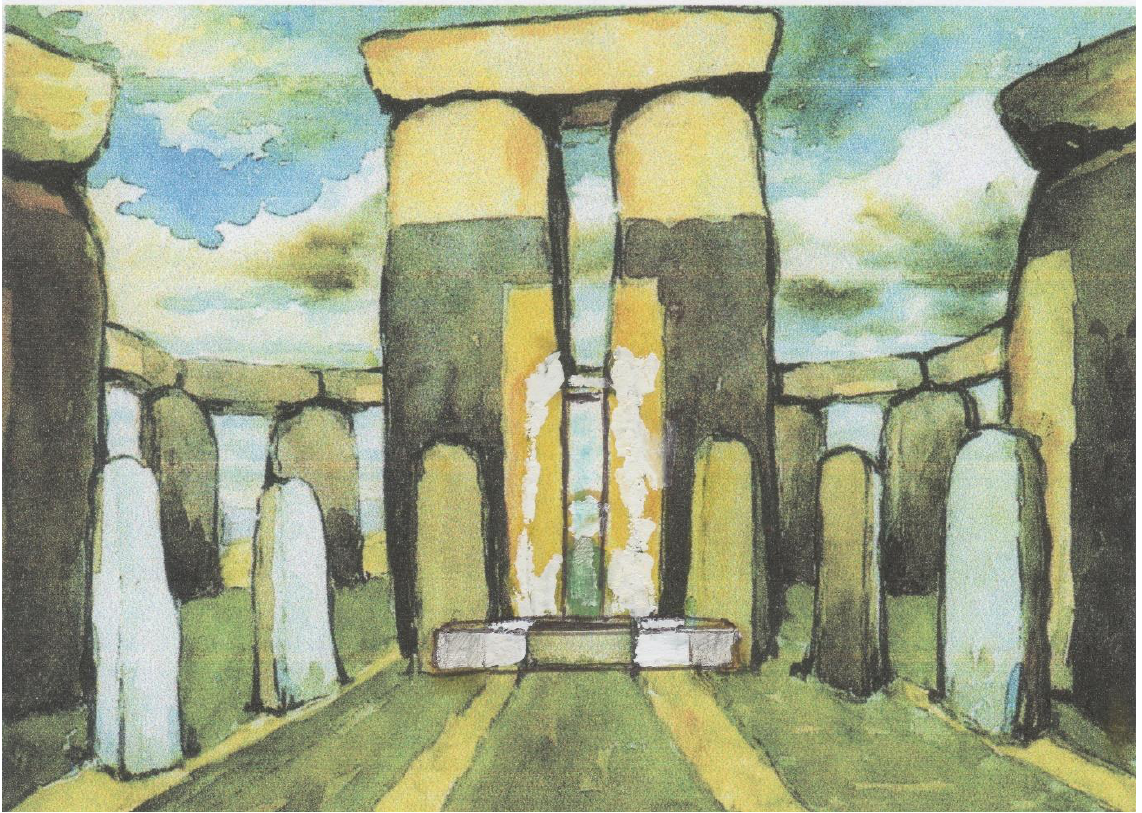
Figure 4. Schematic illustration of how Stonehenge was intended to function in its final phase. The Heel Stone shadow reaches the recumbent Altar Stone - as it still does every midsummer week in clear sunrise conditions. Note, too, that both the Great Trilithon and the Altar Stone are skewed slightly through 10 degrees because that is how the Altar Stone and the standing Great Trilithon Stone 56 are now (see Section 4.1). (Painted by Maureen Oliver with publishing